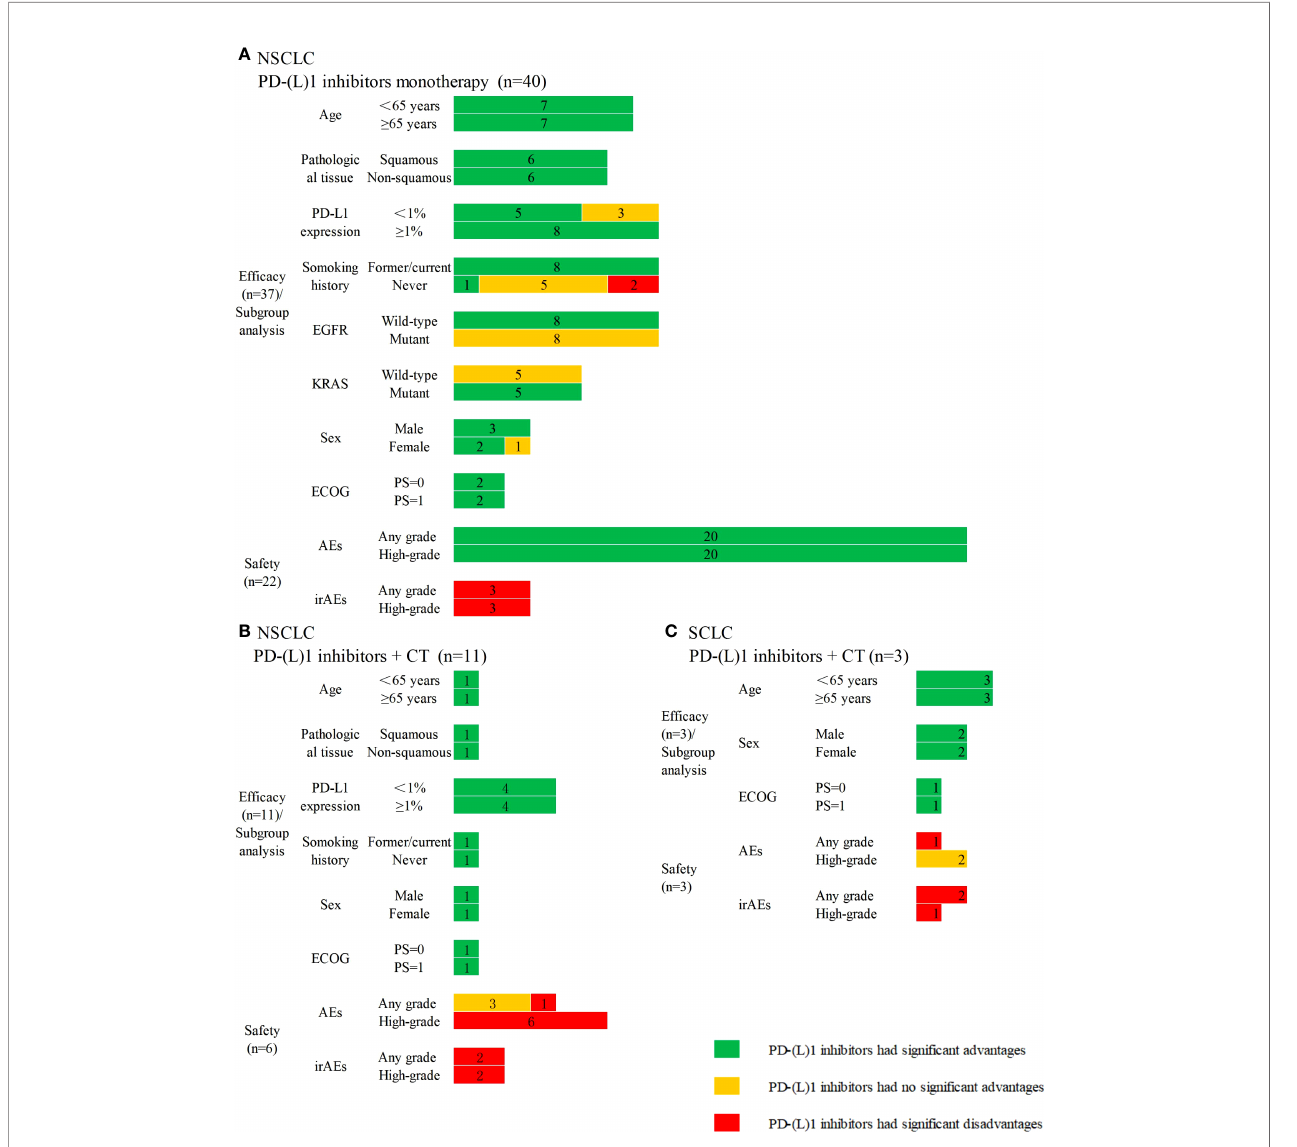
FIGURE 2 | Subgroup analyses and safety results in lung cancer. (A) PD-(L)1 inhibitors monotherapy versus chemotherapy in non-small cell lung cancer; (B) PD-(L) 1 inhibitors plus chemotherapy versus chemotherapy in non-small cell lung cancer; (C) PD-(L)1 inhibitors plus chemotherapy versus chemotherapy in small cell lung cancer. CT, chemotherapy; n, the number of included systematic reviews; EFGR, epidermal growth factor receptor; KRAS, kirsten rat sarcoma viral oncogene; ECOG, Eastern Cooperative Oncology Group; PS, performance status; AEs, adverse events; irAEs, immune-related adverse events; High-grade, ≥ 3